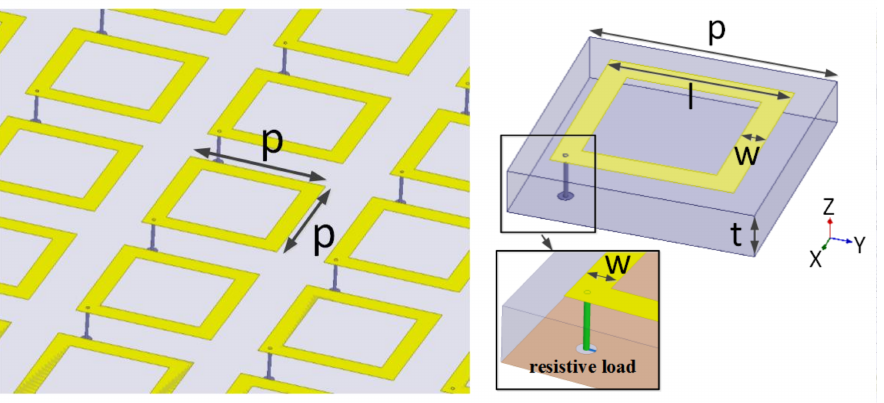
Figure 2. The square-ring resonator metasurface (MS) structure for ambient power harvesting.